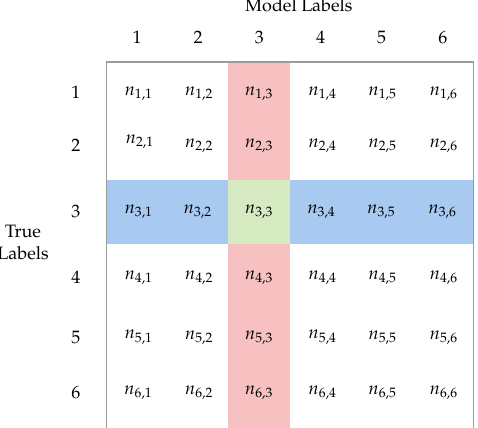
Figure 3. Confusion matrix of an M -class segmentation problem with M = 6. Each element in the matrix, denoted n i , j , is the total number of pixels that belong to class i and predicted as class j by the model. For class 3, the True Positive pixels are represented by the green cell; the False Negative pixels are represented by the blue cells and the False Positive pixels are represented by the red